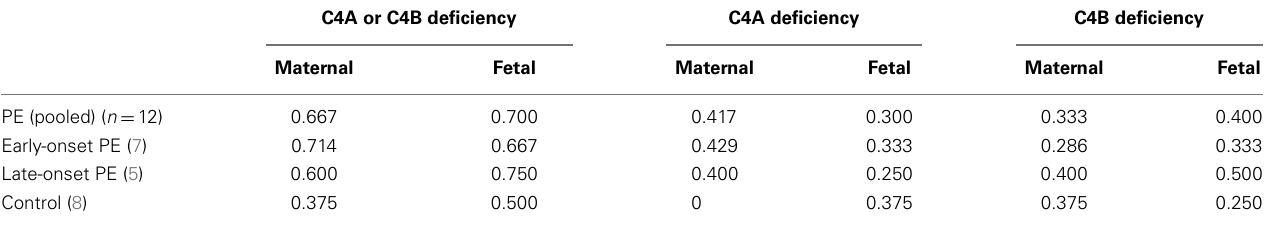
Table 3 | Frequency of C4A and/or C4B deficiencies in preeclamptic (PE) patients and controls . C4A or C4B deficiency C4A deficiency C4B deficiency Maternal Fetal Maternal Fetal Maternal